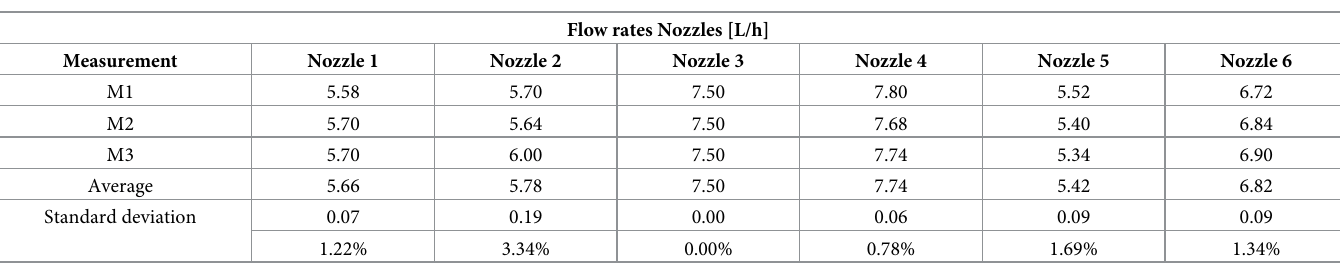
Table 2. Flow rates of the nebulizer nozzles.